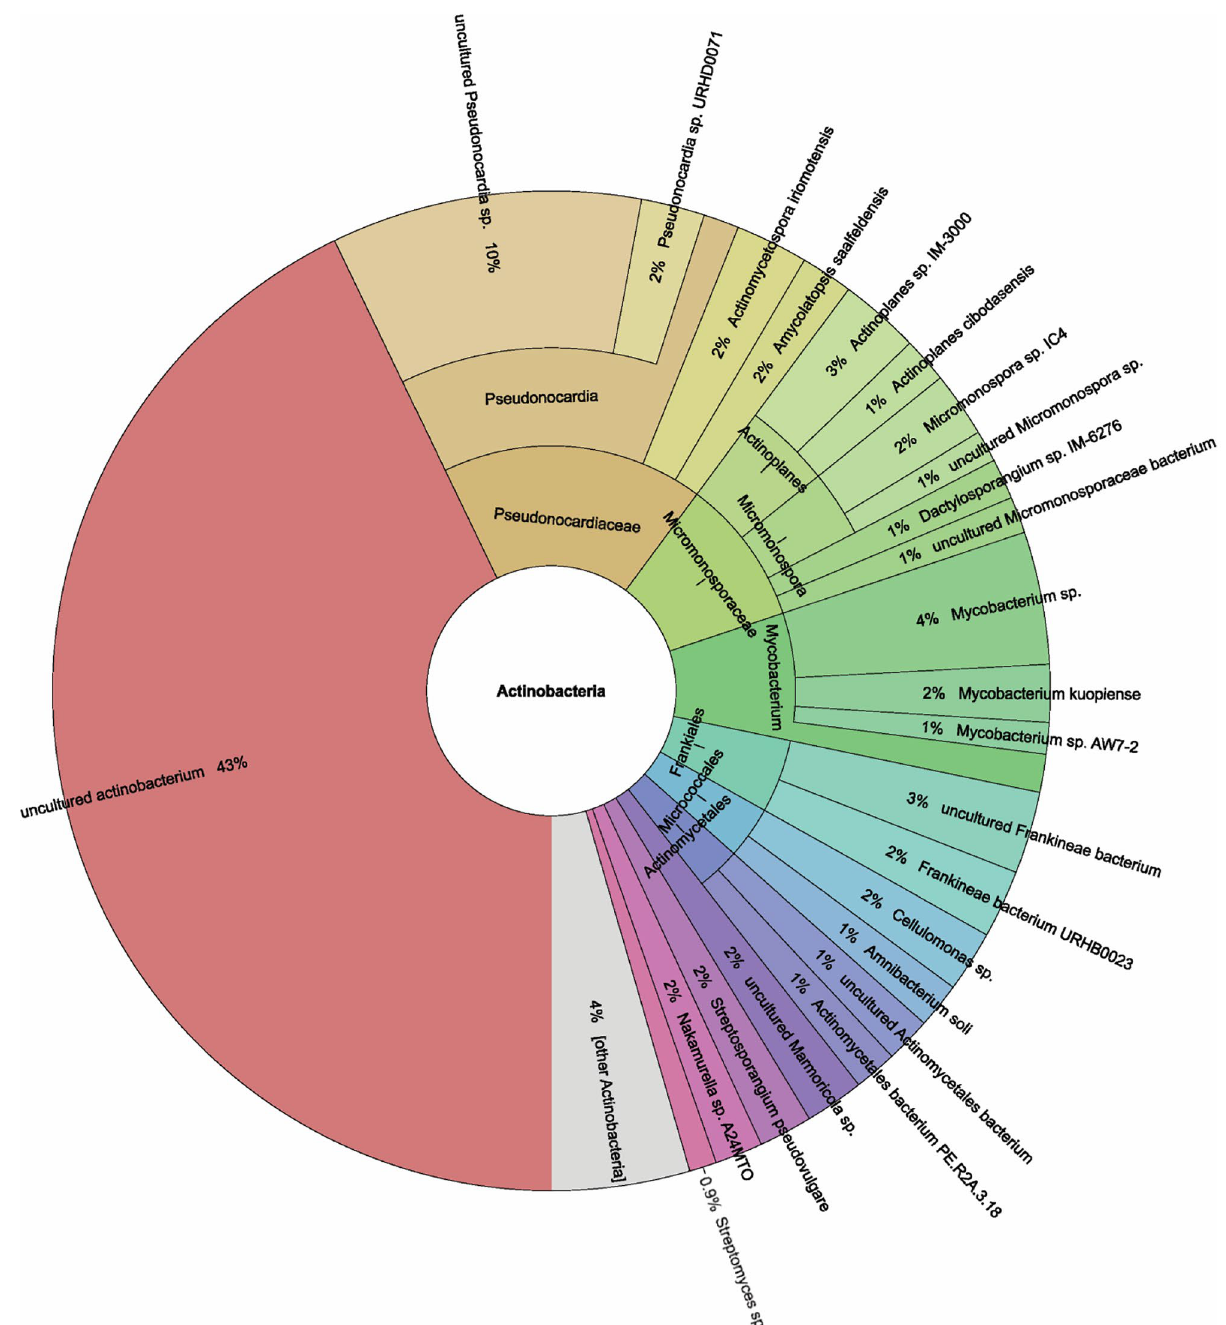
Figure 4. Krona charts visualize the taxonomic spectrum of actinobacteria derived from metagenomic data of the bacterial community found in 10 different lichen species. The circle indicated ascending taxonomic classifications up to the species level (outermost